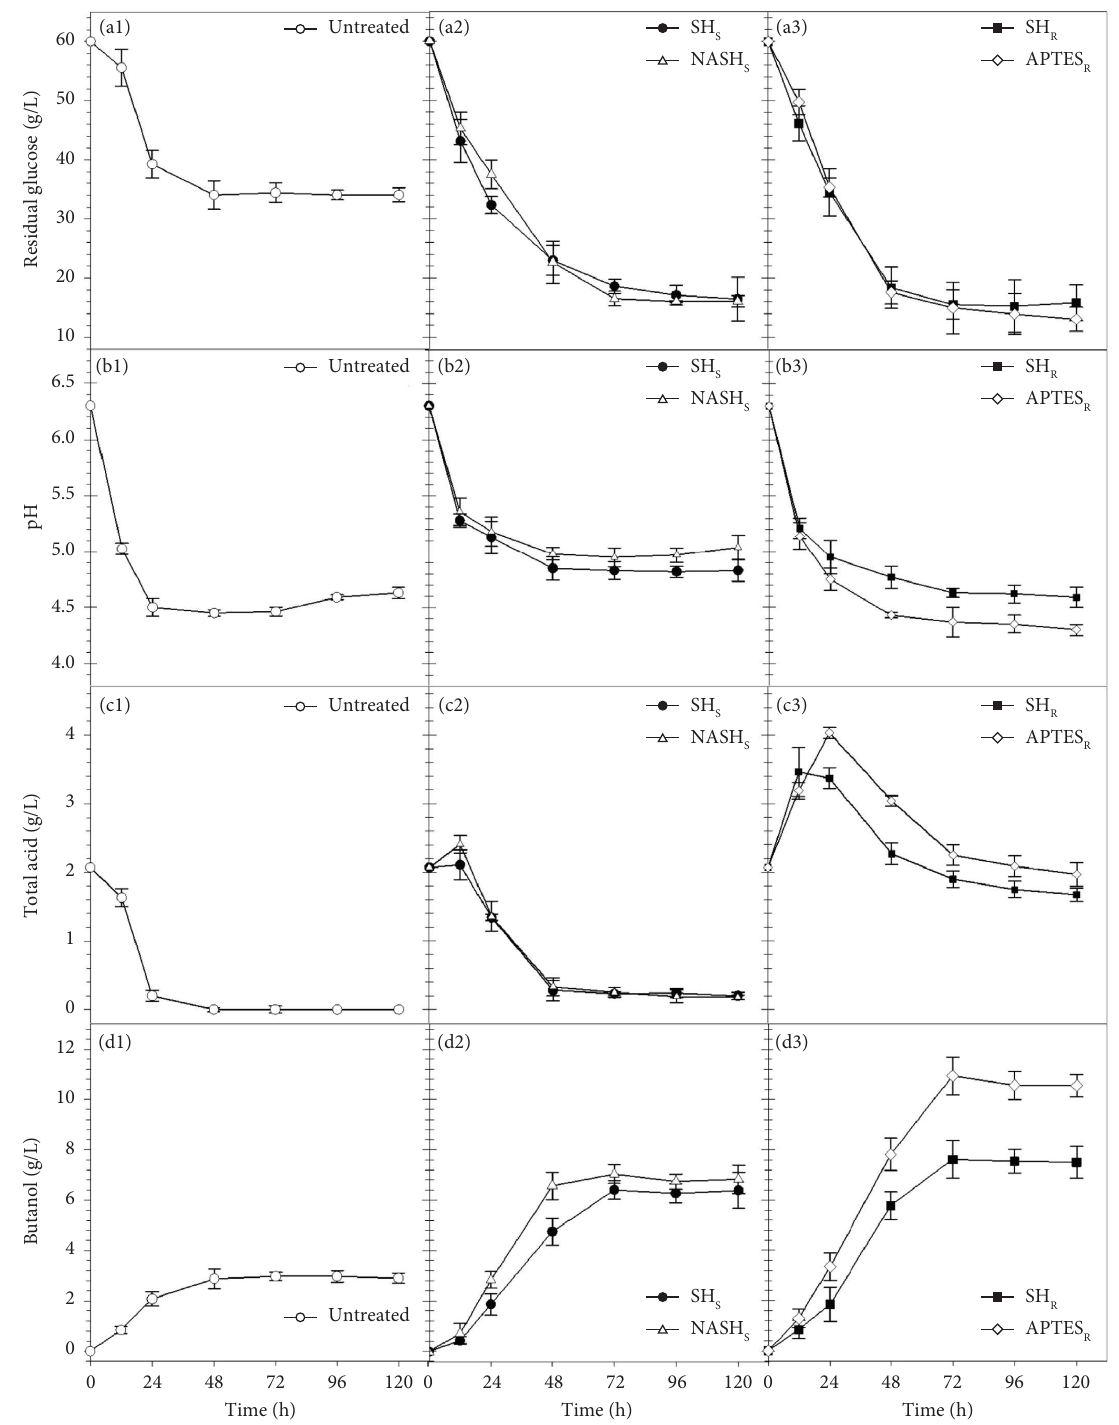
Figure 6: Te ABE fermentation by C. beijerincki i TISTR1461 immobilized on various treated ACs (untreated SH S , NASH S , SH R , and APTES R ) showing the levels of (a) residual glucose, (b) pH, (c) total acids, and (d) butanol. Data are shown as the mean ± SD, derived from three replicated independent of treated ACs. Te dimension of Clostridium sp. cells has to compare and fnd an ideal material to achieve both a high previously been reported to be about 500 nm diameter and butanol concentration and productivity. 2-3 μ m length [35], so the bacteria can move and grow Te SEM images (Figure 7) confrmed the immobili- through the cracks of the treated AC samples (Figure S4). zation of C. beijerinckii TISTR1461 on/into the various types